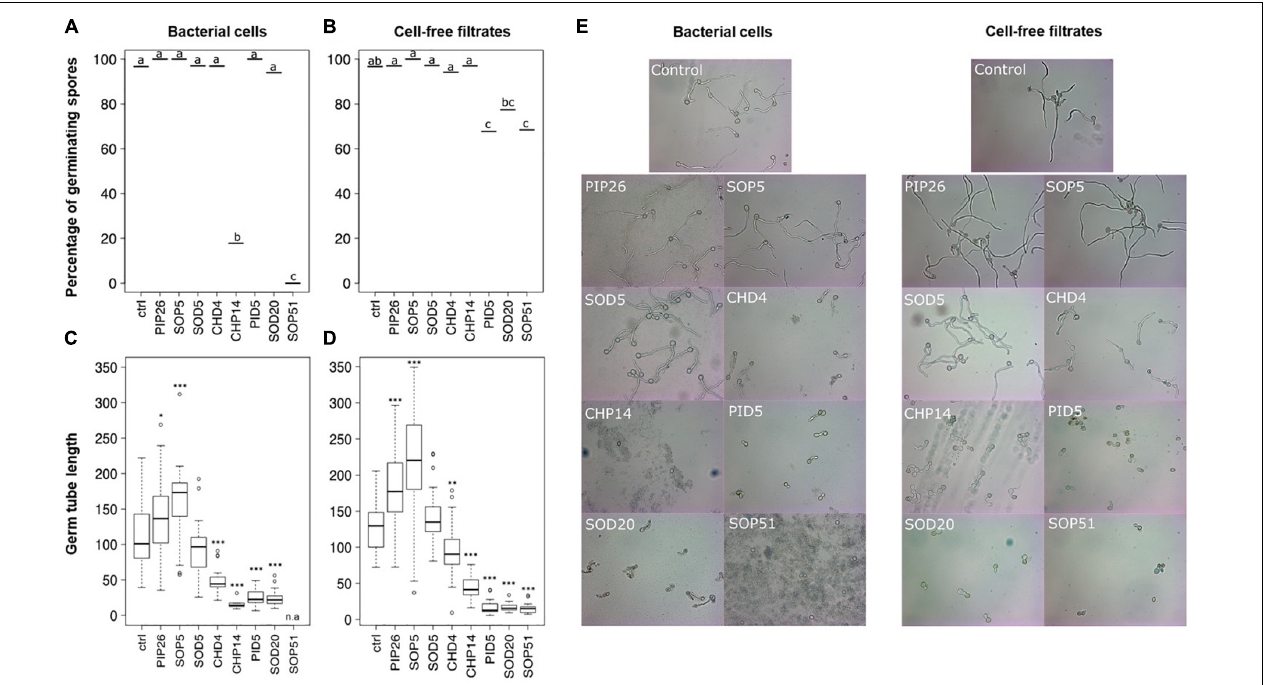
FIGURE 4 | Inhibition of spore germination of Botrytis cinerea. Percentages of germinated spores observed (out of ca. 30 spores) after 8h upon exposure to bacterial cells are shown in (A) , those observed upon exposure to cell-free filtrates are shown in (B) . Different letters indicate statistically significant differences according to a Chi-square test with Yate’s correction for continuity ( p < 0.05). The length of the germ tube was measured with ImageJ in germinated spores exposed to bacterial cells ( n = 5–39) (C) or cell-free filtrates ( n = 21–34) (D) . Stars indicate significant difference in germ tube length compared with the respective control (ctrl) according to a t -test ( ∗ p < 0.05; ∗∗ p < 0.01; ∗∗∗ p < 0.001). n.a., not available (no spore germinated in this treatment). Representative pictures of spores co-incubated with bacterial cells (left) or cell-free filtrates (right) are shown in (E) . The experiment was repeated twice with similar